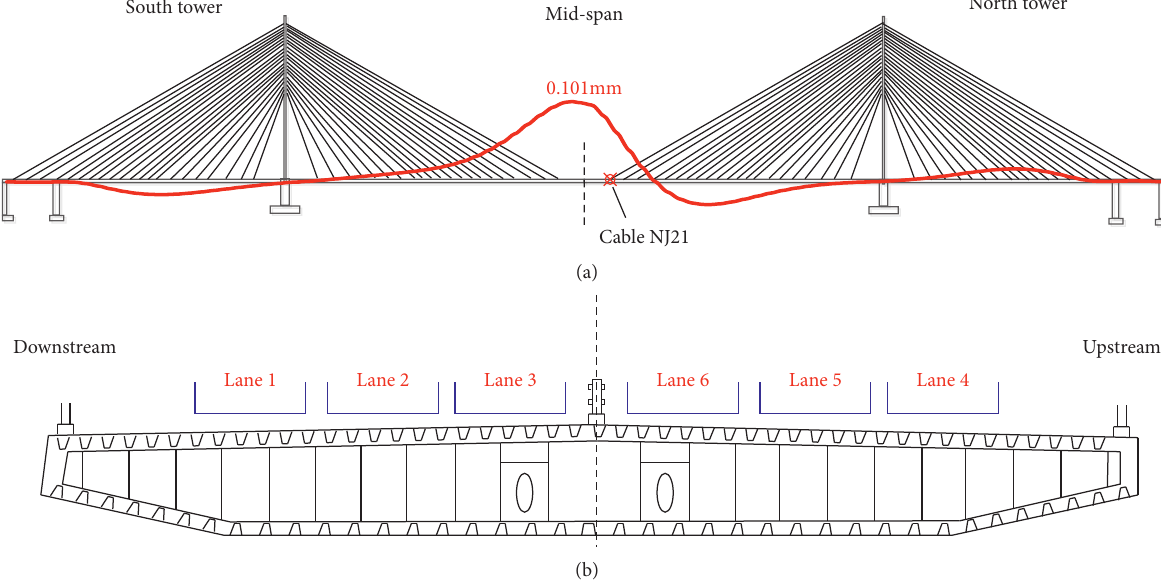
Figure 13: The random vehicle loading procedure: (a) cable force influence line for NJ21; (b) layout of lanes.